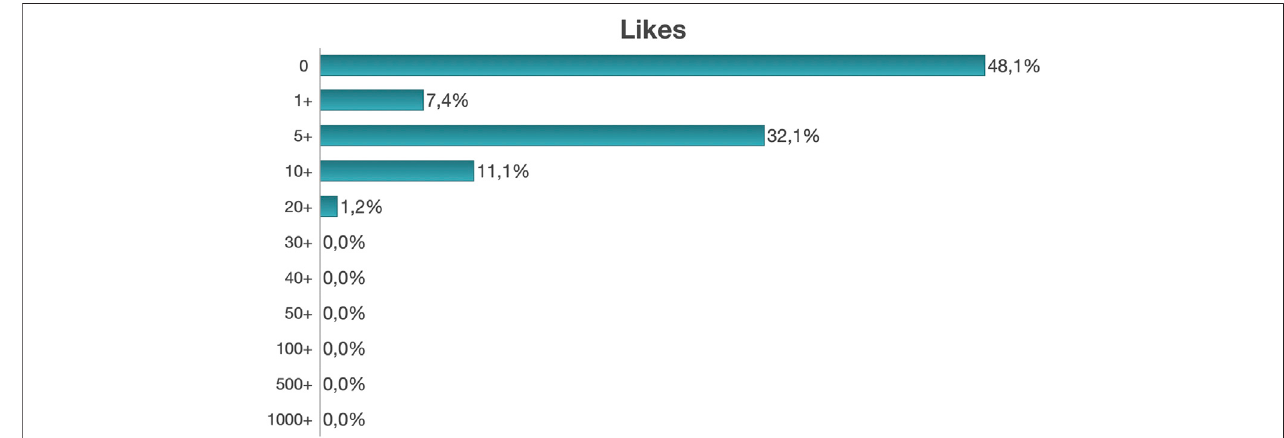
FIGURE 2 | Volume of likes of the ABCA Twitter posts.